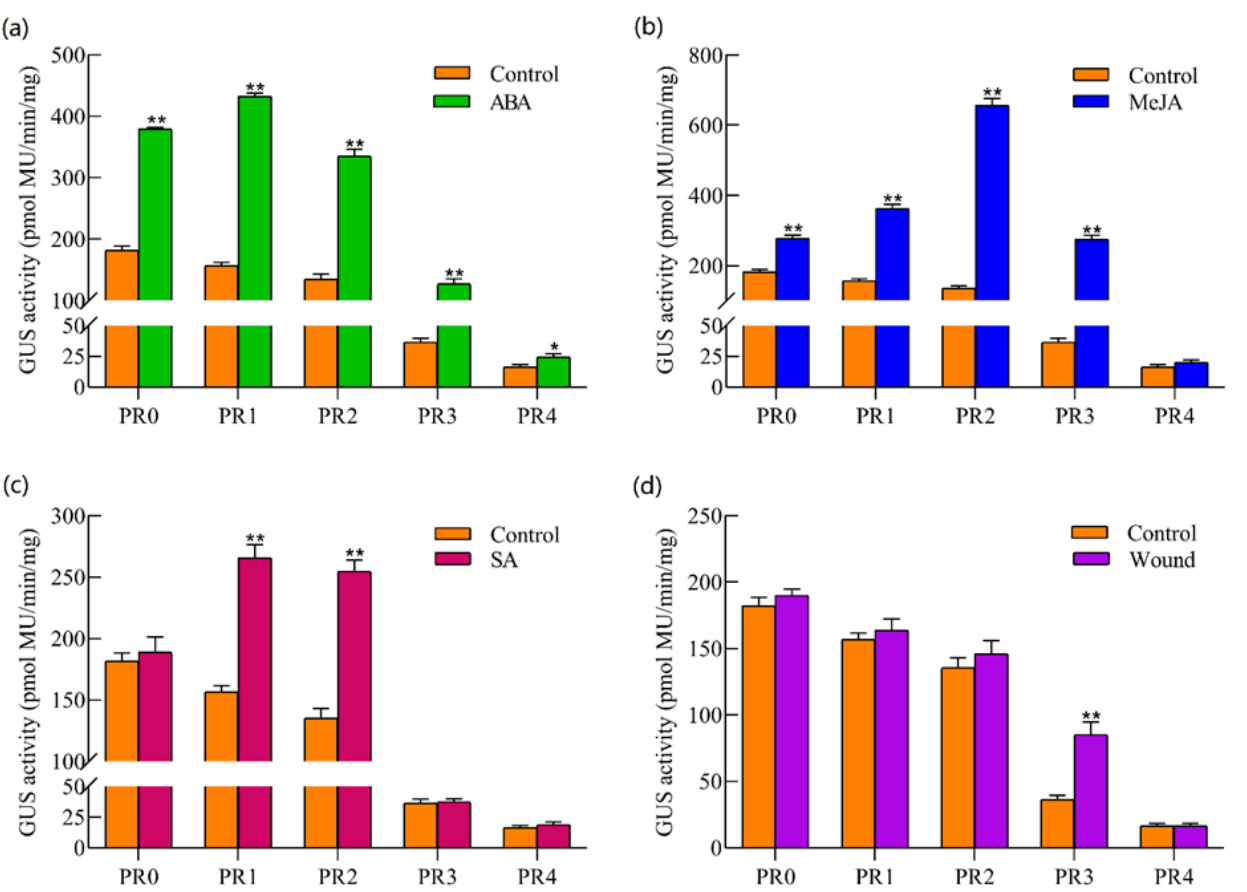
Figure 5. Assessment of stress and hormone responsiveness of the TkSRPP promoter and its deletion fragments. ( a – d ): The GUS activity analysis of five deletion promoters in response to abscisic acid (ABA), methyl jasmonate (MeJA), salicylic acid (SA) and wound treatment, respectively. The bars represent standard errors, and the asterisks indicate statistical significance determined by the student’s t -test (* p ≤ 0.05, ** p ≤ 0.01 ).